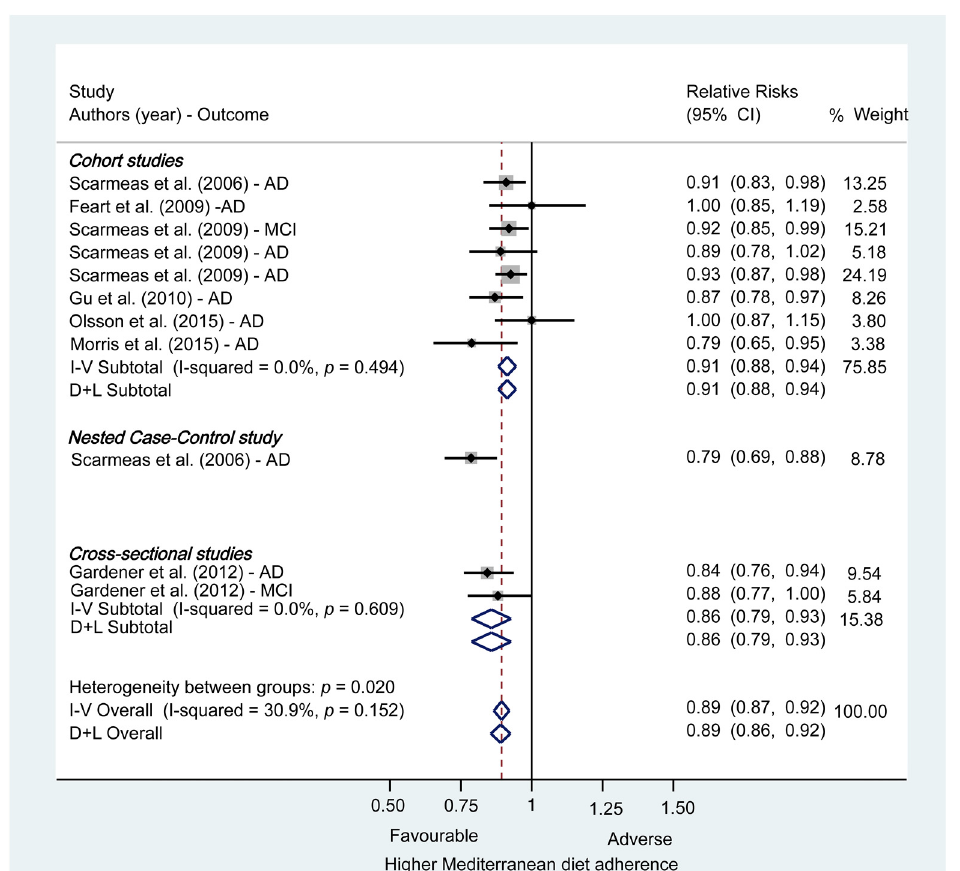
Figure A1. Mediterranean diet adherence and risk of Alzheimer’s disease or mild cognitive impairment: a subgroup analysis according to study design. CI = confidence interval; AD = Alzheimer’s disease; MCI = Mild cognitive impairment; I-V = Mantel-Haenszel method (fixed-effects model); D + L = DerSimonian and Laird method (random-effects model.